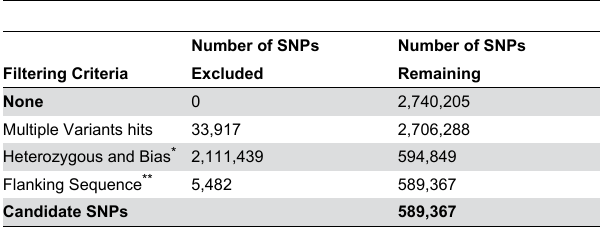
Table 3. Summary of SNP filtering criteria and discovery pipeline results.